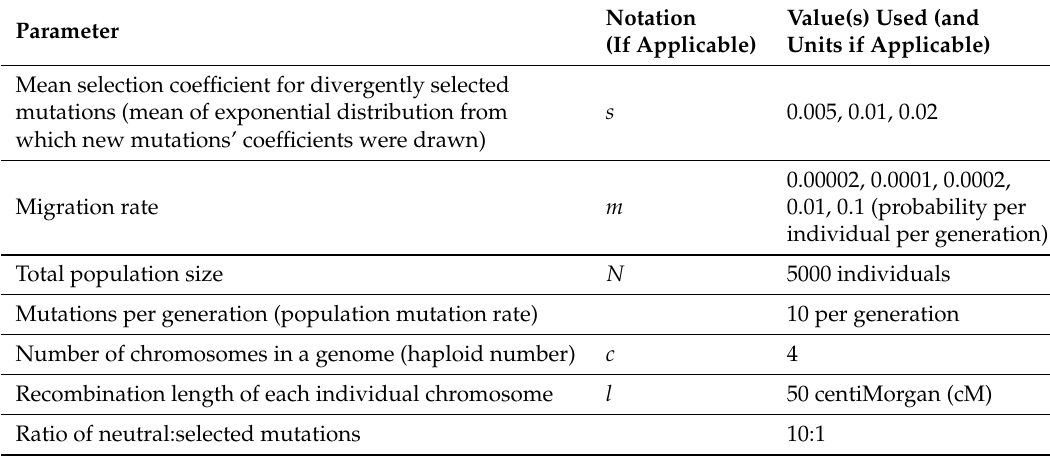
Table 1. Parameter values used in simulations. See Table 2 for the combinations of s and m values used.